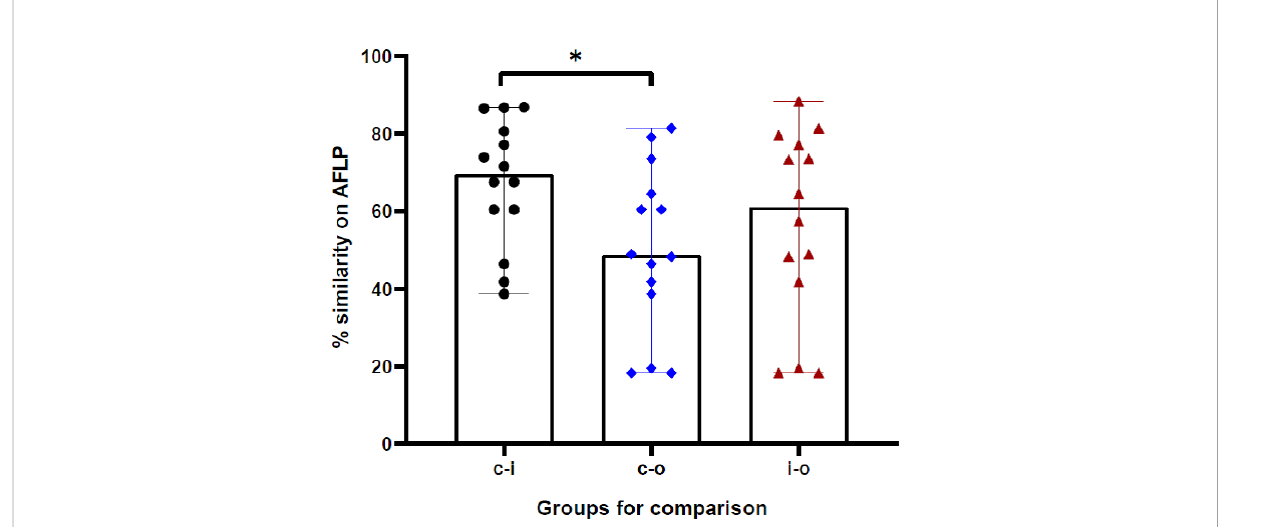
FIGURE 4 The percentage genotypic similarity based on ampli fi ed fragment length polymorphism (AFLP) between clinical and indoor isolates (c-i), clinical and outdoor isolates (c-i), and indoor and outdoor isolates (i-o) obtained from 14 cases in the study. *p-value